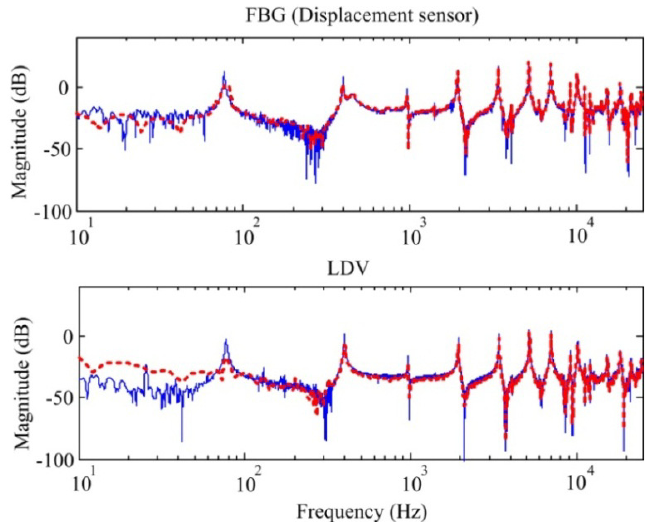
Figure 18. Frequency responses obtained by the FBG displacement sensor and LDV with short measurement